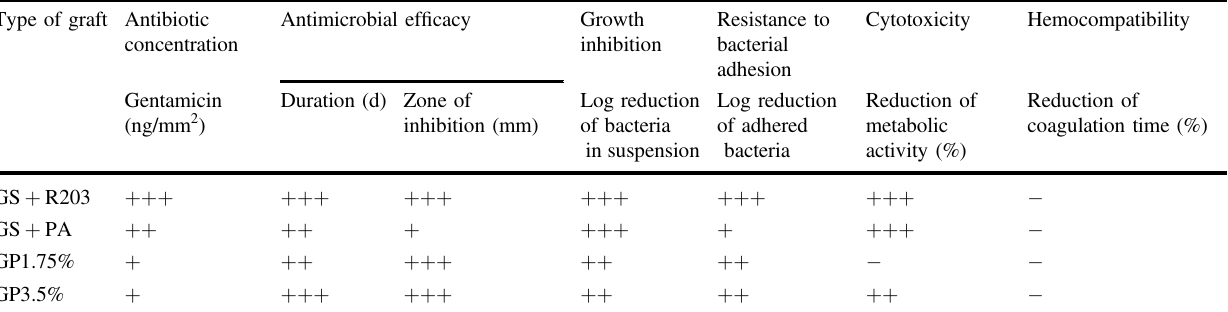
Table 5 Rating levels used for the comparative evaluation of different grafts